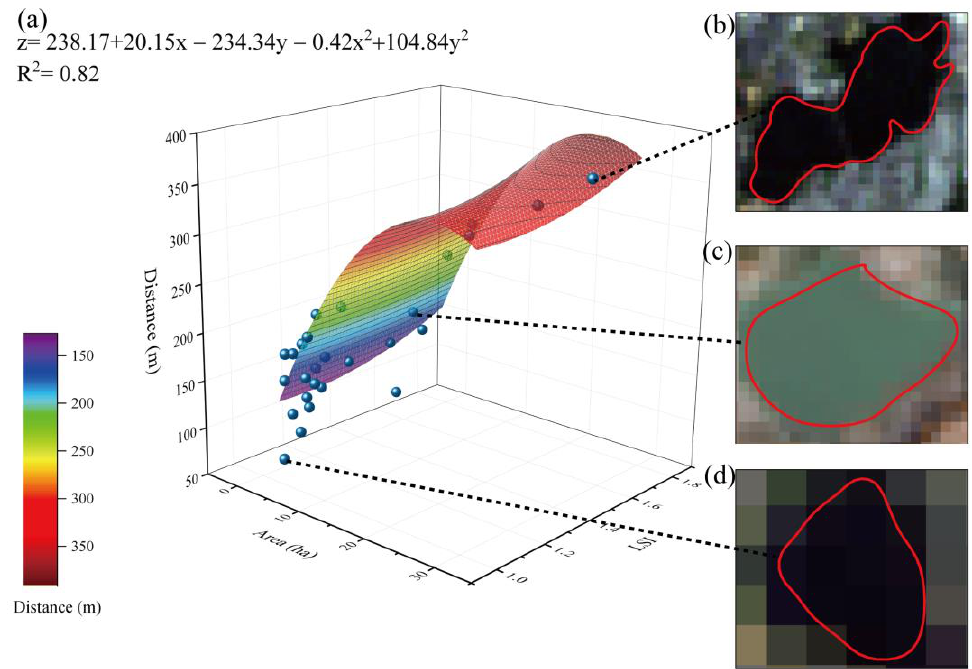
Figure 7. Relationships among the blue space area, LSI, and cooling distance. ( a ) Function description; ( b ) sample 1, a blue space with an area of 29.99 ha and LSI of 1.52; ( c ) sample 2, a blue space with an area of 5.05 ha and LSI of 1.06; and ( d ) sample 3, a blue space with an area of 1.01 ha and LSI of